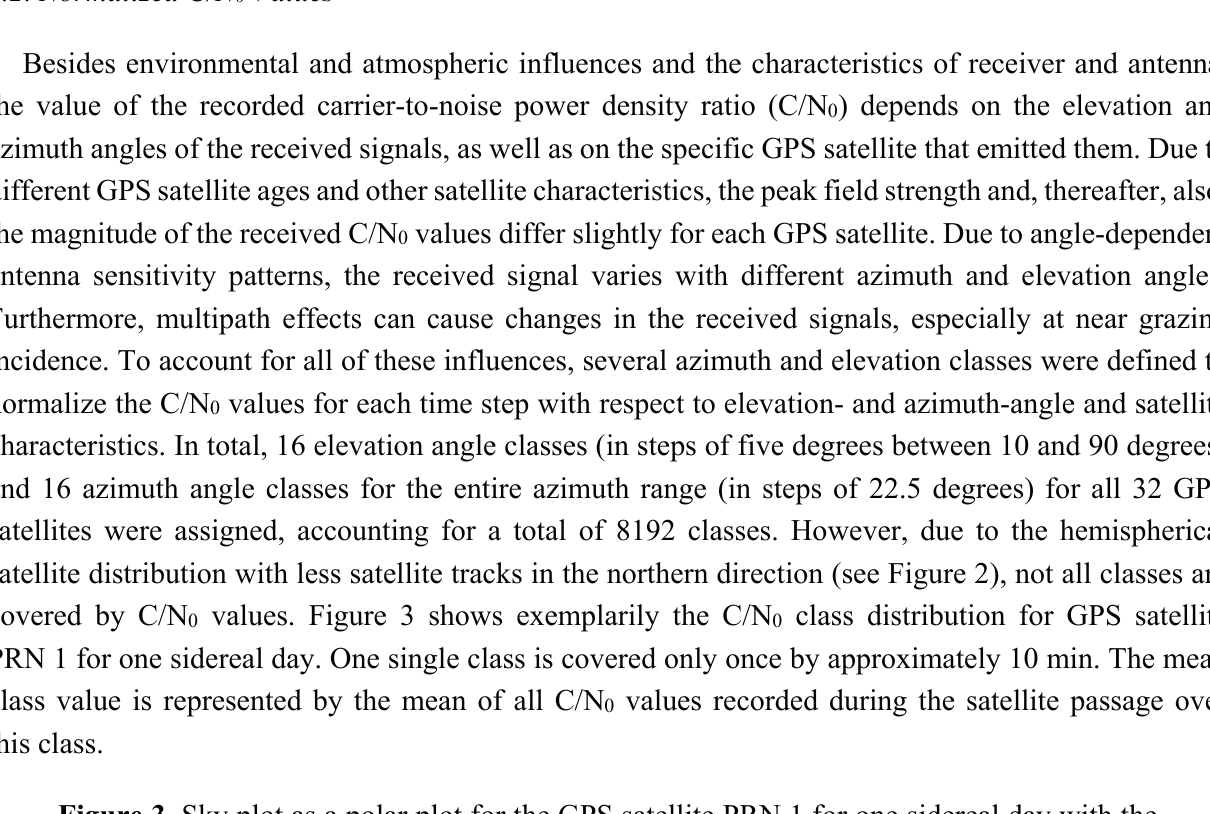
Figure 3. Sky plot as a polar plot for the GPS satellite PRN 1 for one sidereal day with the classification of the C/N 0 values with 16 elevation and 16 azimuth classes. The classes assigned with values for PRN 1 are colored blue. C/N 0 values below an elevation angle of 10° were masked out for the calculation (these areas are marked